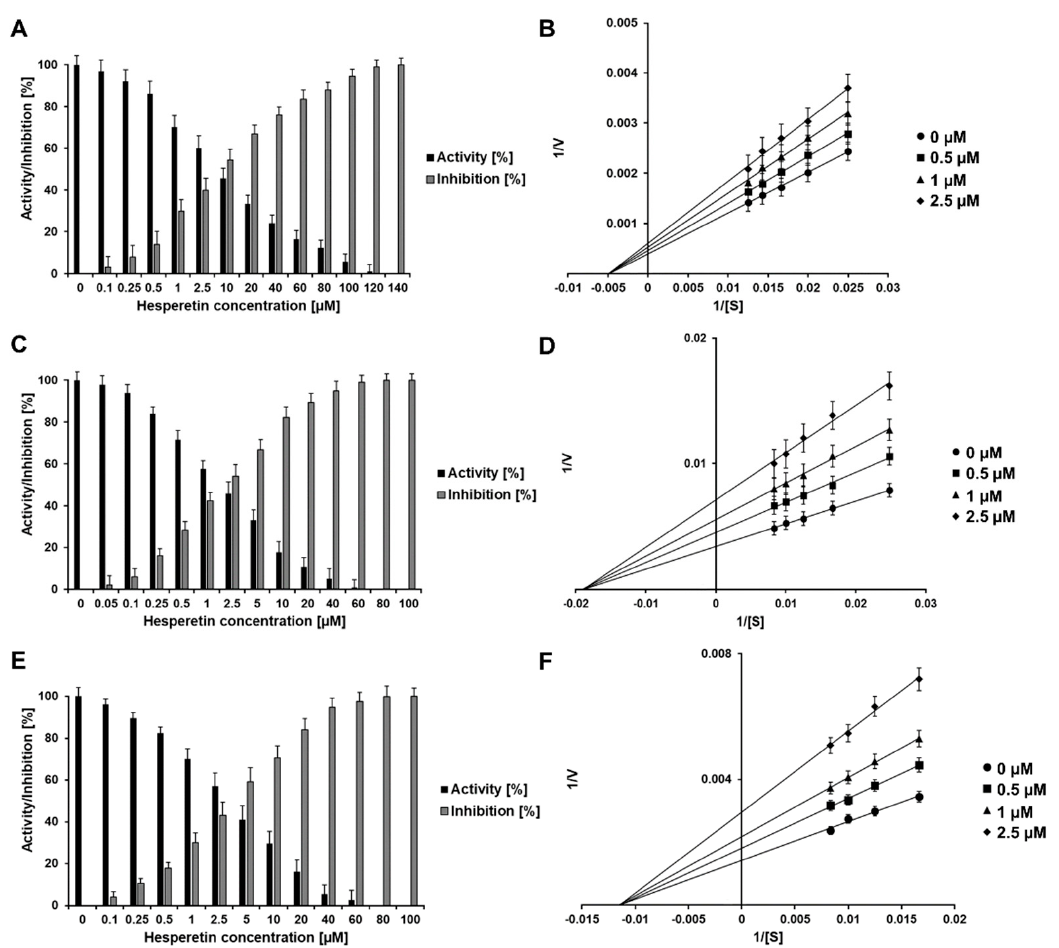
Figure 3. Normalized activity, inhibition effect and inhibition mode of HST over DENV2, YFV, and WNV NS2B/NS3 pro . Lineweaver-Burk plots were used to determine the inhibition modes. [S] is the substrate concentration; v is the initial reaction rate. Inhibition of DENV2, YFV, and WNV NS2B/NS3 pro by HST are shown in ( A , C , E ), respectively. Lineweaver-Burk plots for HST inhibition of DENV2, YFV, and WNV NS2B/NS3 pro are shown in ( B , D , F ), respectively. Data shown are the mean ± SD from 3 independent measurements ( n = 3). Table 1. Inhibitor key numbers and inhibition modes of HST and HSD for DENV2, YFV, WNV, and ZIKV NS2B/NS3 pro .